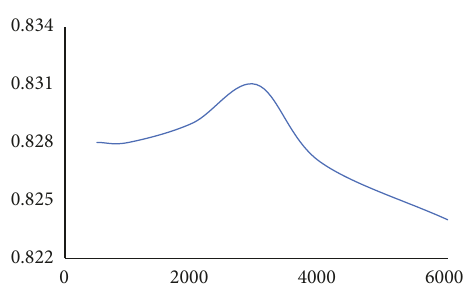
Figure 5: Number of words comparison in terms of